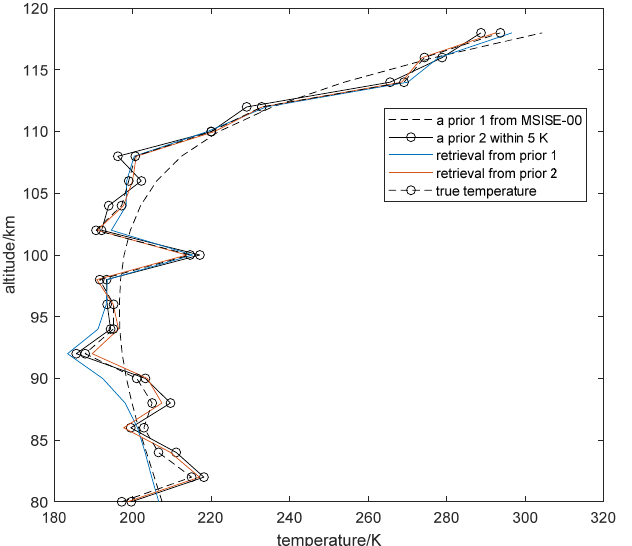
Figure 19. Retrieval of atmospheric temperature in MLT region based on different a priori constraints.